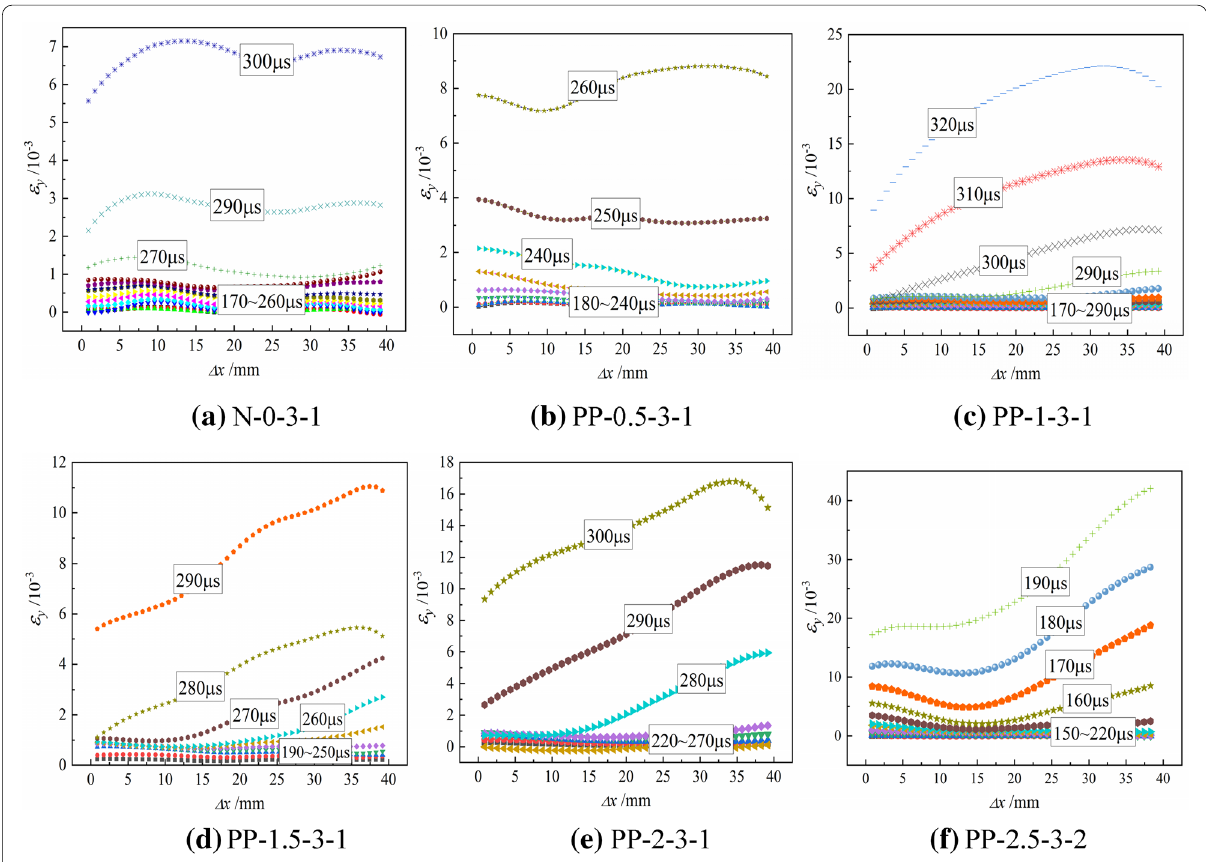
Fig. 15 Strain on ST line of each group of specimens under impact velocity of 3 m/s